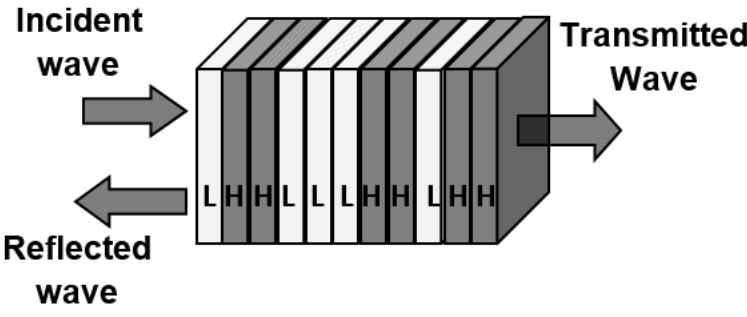
Figure 1. Schematic representation showing the geometry of the 4 th generation of Generalized Fibonacci photonic GF (1, 2) structure.